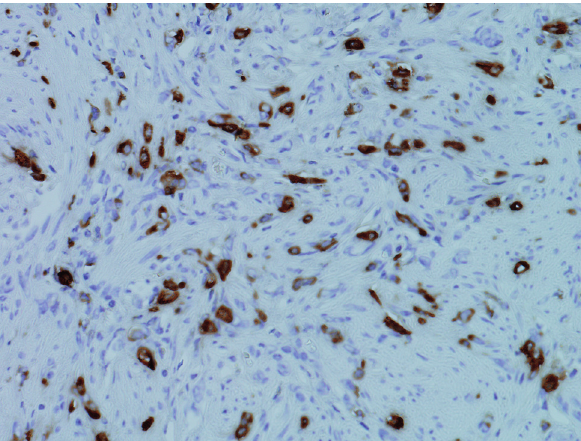
Fig. 3. Adenocarcinoma ex-goblet cell carcinoid cells are posi- tive with a marker against synaptophysin (synaptophysin, 200x).